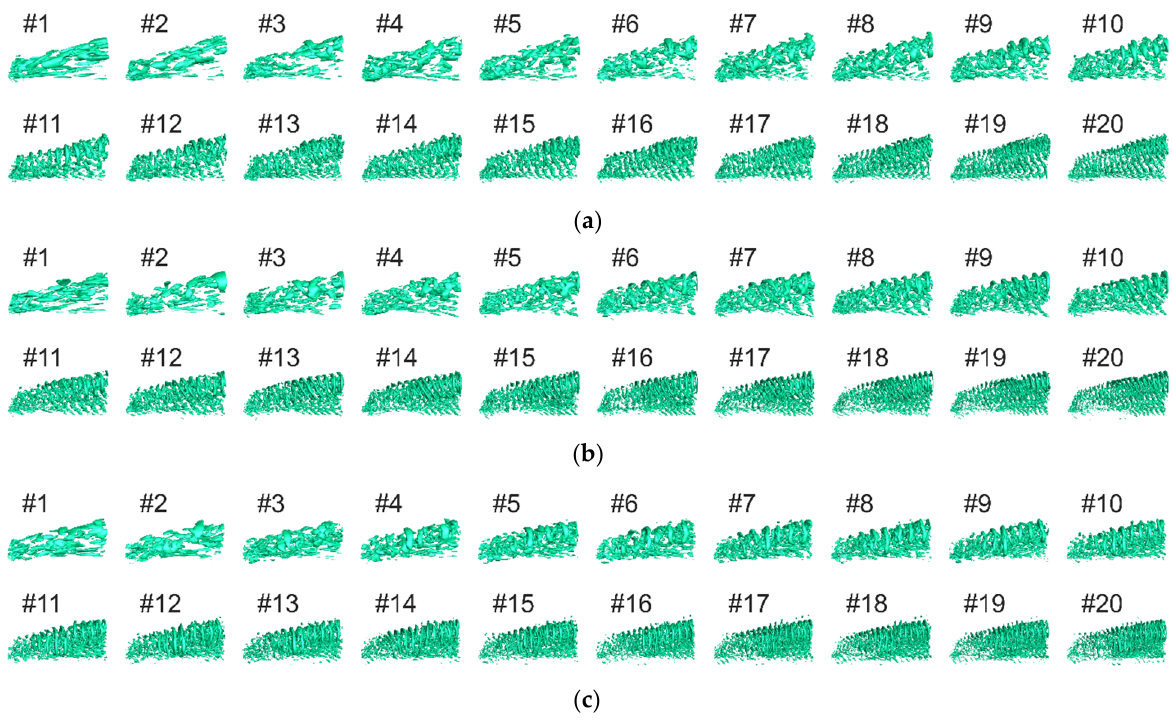
Figure 8. The energy percentage of the first 20 modes behind the MVG in three different Mach numbers.